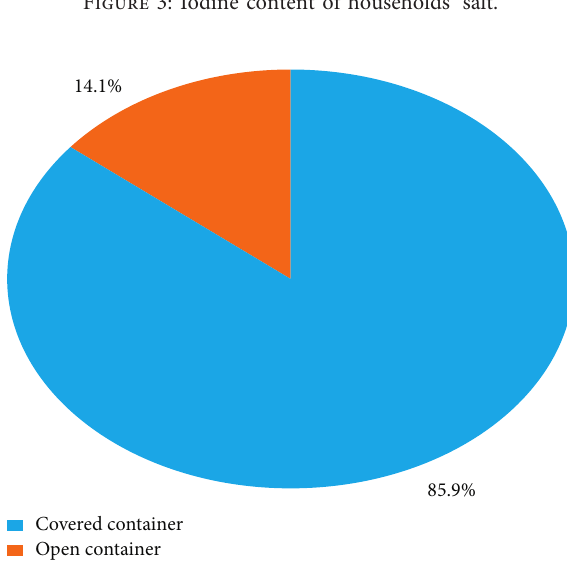
Figure 3: Iodine content of households’ salt.